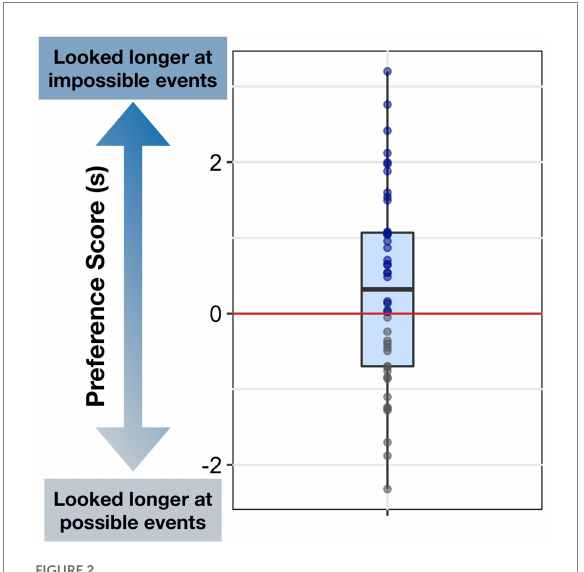
FIGURE 2 Individual differences in infants’ Preference Score. The y-axis represents infants’ Preference Score for the impossible events, calculated by subtracting the looking time at possible events from the looking time at the matching impossible events. Preference Scores higher than 0 = looked longer at impossible events (blue dots); Preference Scores lower than 0 = looked longer at possible events (gray